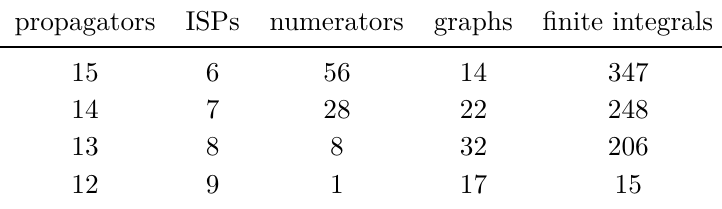
Table 2 . Counts of non-isomorphic vacuum graphs (see figure 6) by number of edges